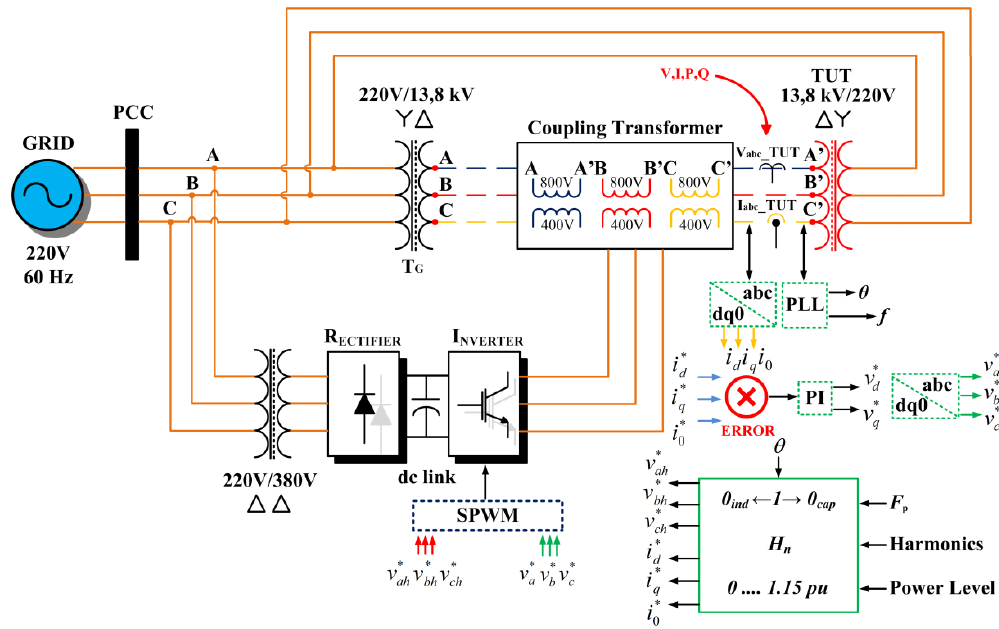
Figure 6. Topology proposed for TUT transformer test, showing control strategy and test scenarios.